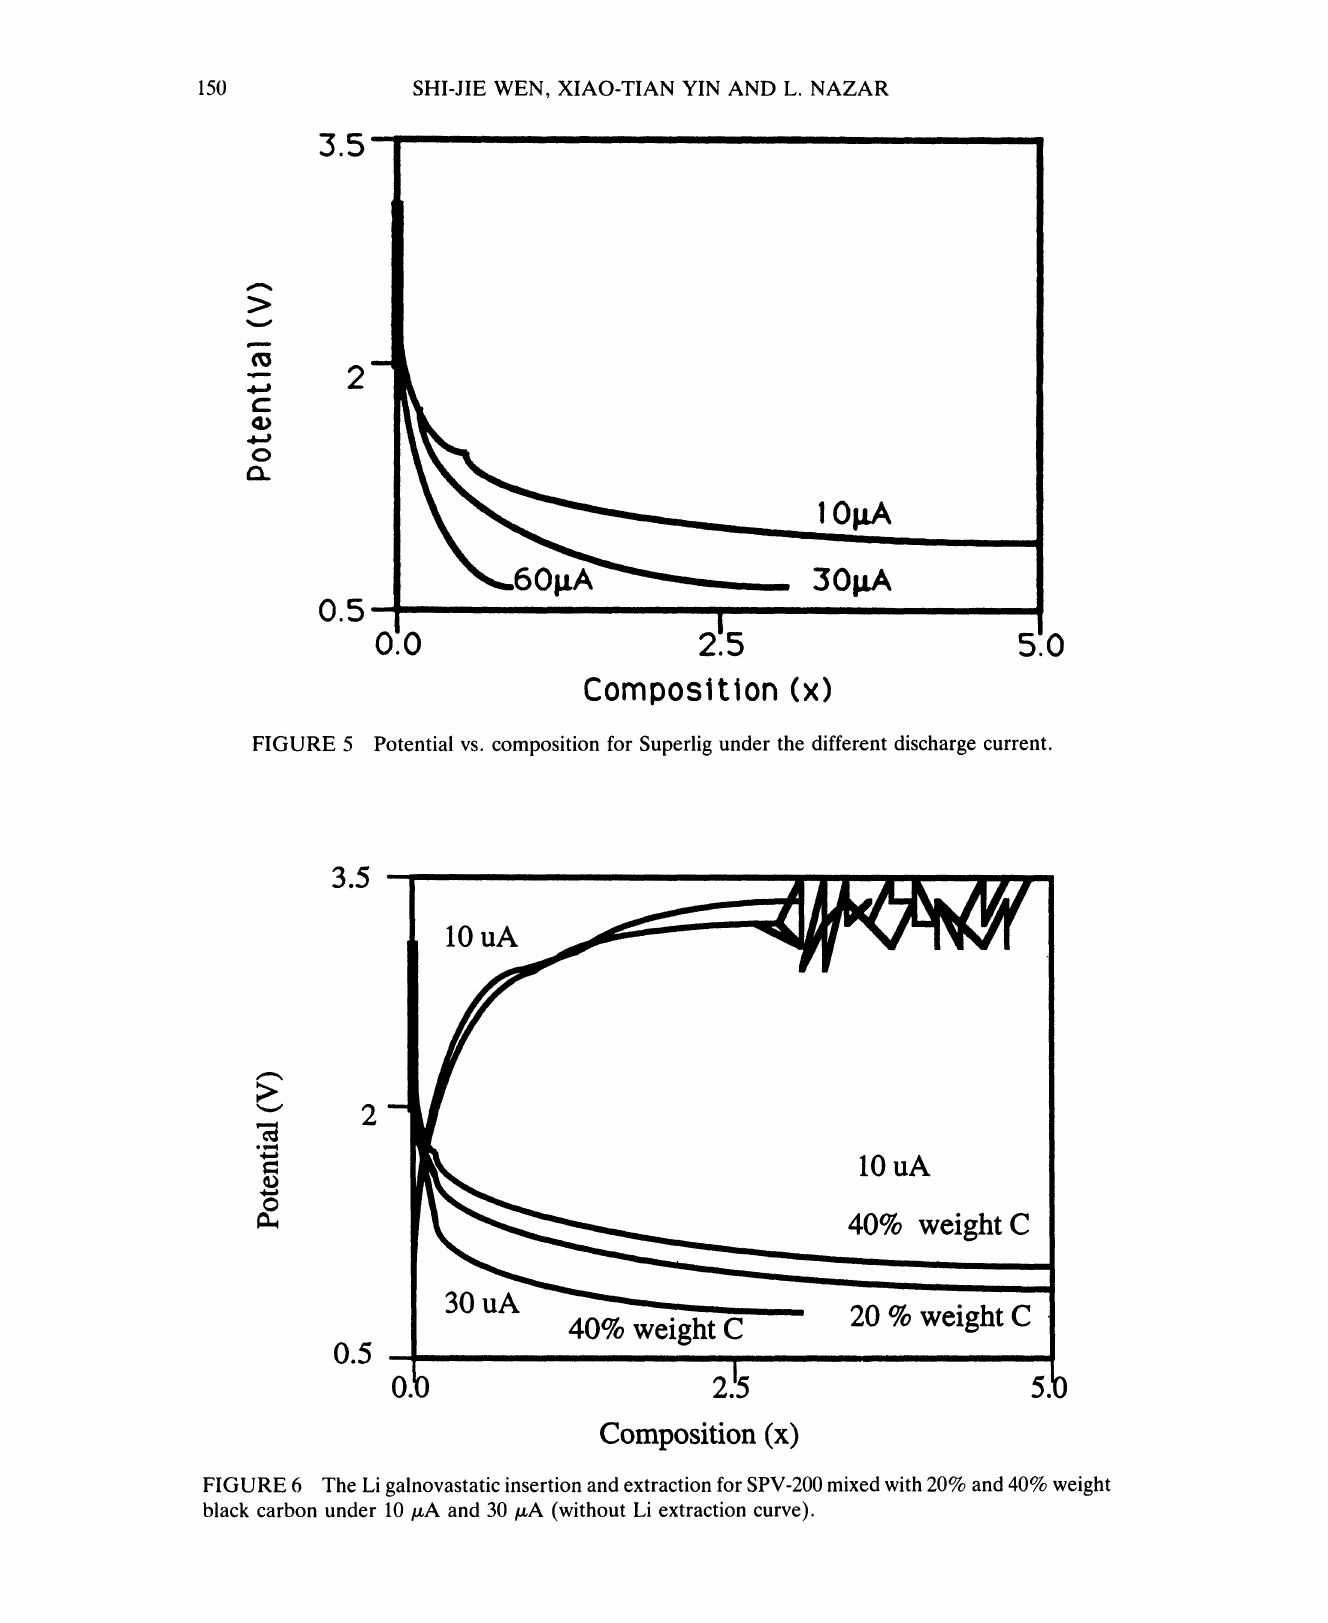
FIGURE 6 The Li galnovastatic insertion and extraction for SPV-200 mixed with 20% and 40% weight black carbon under 10/zA and 30/zA (without Li extraction